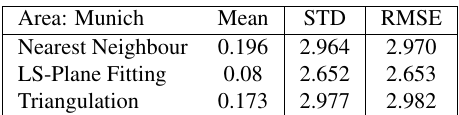
Table 2. The height accuracy assessment of the achieved point clouds from the 3D reconstruction of optical-SAR image pair over study subsets in Munich by different methods